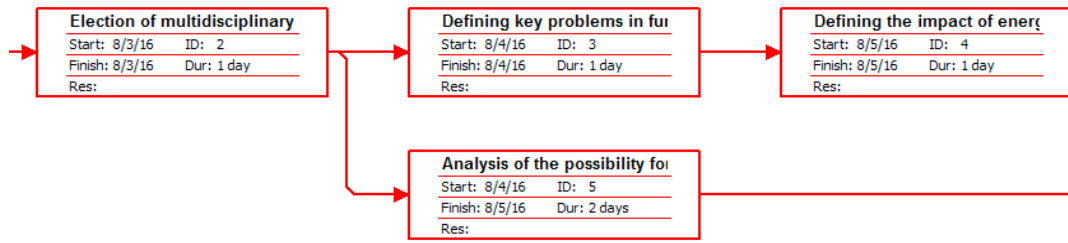
Figure 6. Illustrative part of network diagram of the initial phase of the project to improve the environmental protection system in mining and energy complexes.